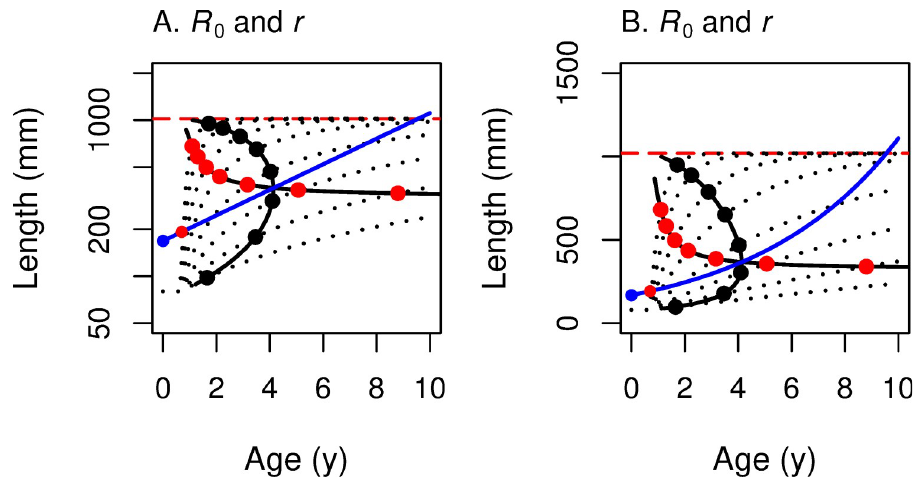
Fig 7. Growth trajectories with maturation reaction norms maximizing r (horizontal line) and R 0 (bowed vertical line). This figure summarizes for von Bertalanffy growth trajectories (dotted lines) what Fig 4 summarized for linear growth; red dots show where r is maximized and black dots show where R 0 is maximized along each growth trajectory. (A) With log-length on the vertical axis, the underlying iso-fitness curves are straight lines (shown only as the blue line that corresponds to R 0 = 1 or r = 0; see Fig 6A and 6C). (B) With linear-length on the vertical axis, the underlying iso- fitness lines are curved (blue line corresponds to R 0 = 1 or r = 0; see Fig 6B and 6D). In both panels, the reaction norm for fitness function R 0 is bowed out to the right (optimal maturation age stays in a narrow range as growth rate varies), while the reaction norm for fitness function r is mostly horizontal (optimal maturation size changes little as growth rate varies).